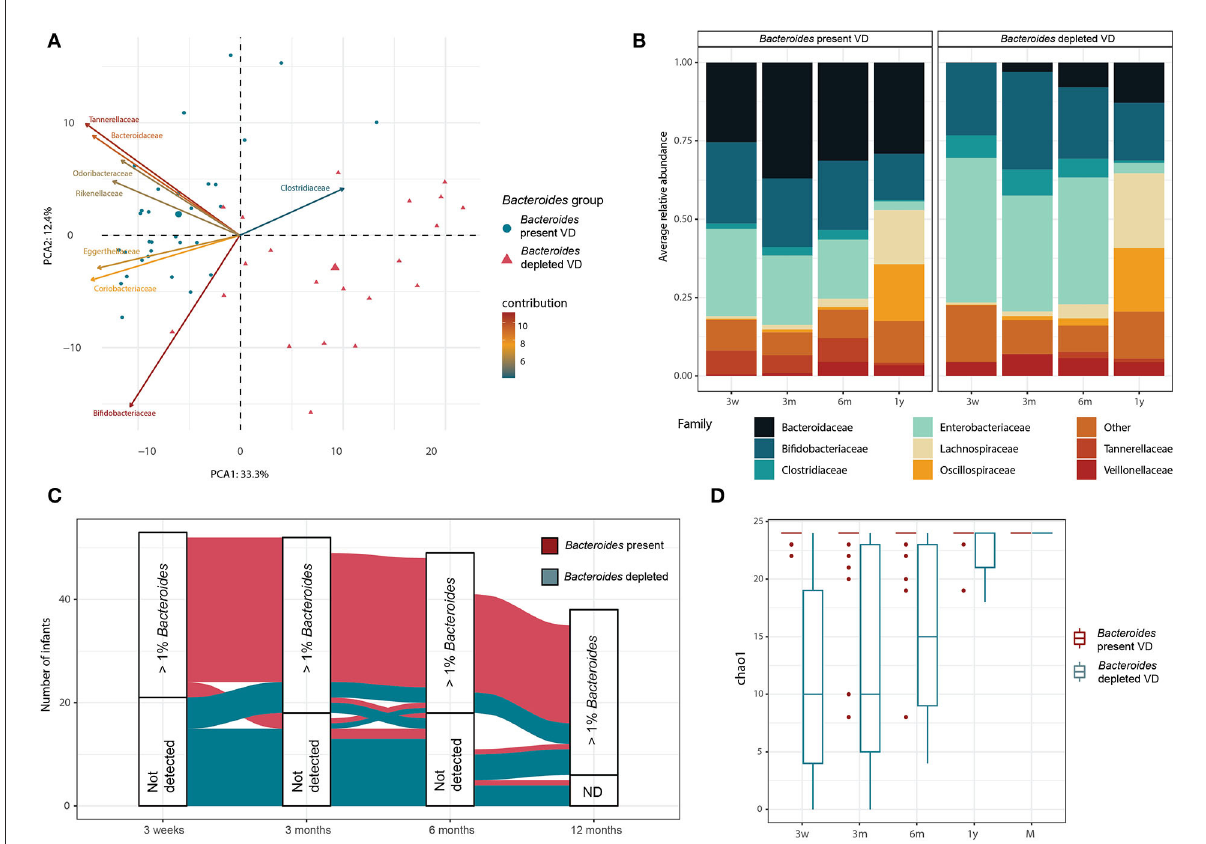
FIGURE4 Depletion of genus Bacteroides in a subset of VD infants. (A) PCA biplot based on family-level taxonomic profiles for VD infants at 3 weeks of age. Taxonomic profiles obtained for the 3-week samples were aggregated at the family level, and low abundance taxa were excluded before computing an Aitchinson distance between samples. Samples in the PCA biplot are colored as per the groups based on relative abundance of Bacteroides genus. Bacterial families contributing most to the observed variation were plotted as arrows on the biplot. (B) Average microbiota composition for infants grouped by the abundance of Bacteroides at 3 weeks. Taxonomic profiles are aggregated at the family level, and families with below 10% of relative abundance and prevalence are summed and grouped as “Other.” (C) Alluvial plot showing the evolution over the first year of life of infants according to the relative abundance of Bacteroides . A cutoff of 1% relative abundance of Bacteroides was chosen to group the samples, and the infants are colored by the relative abundance of Bacteroides at 3 weeks. (D) The taxonomic richness of the Bacteroides species (Chao1 index) in the infants and their respective mothers according to Bacteroides relative abundance at 3